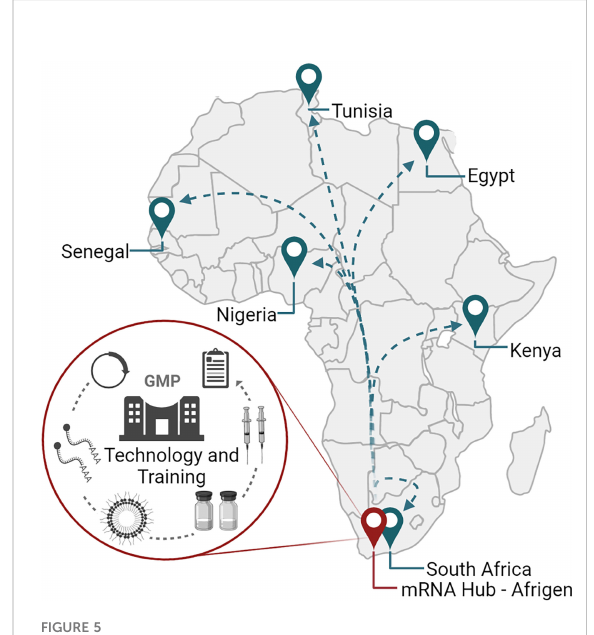
FIGURE 5 The mRNA vaccine technology hub and spokes program in